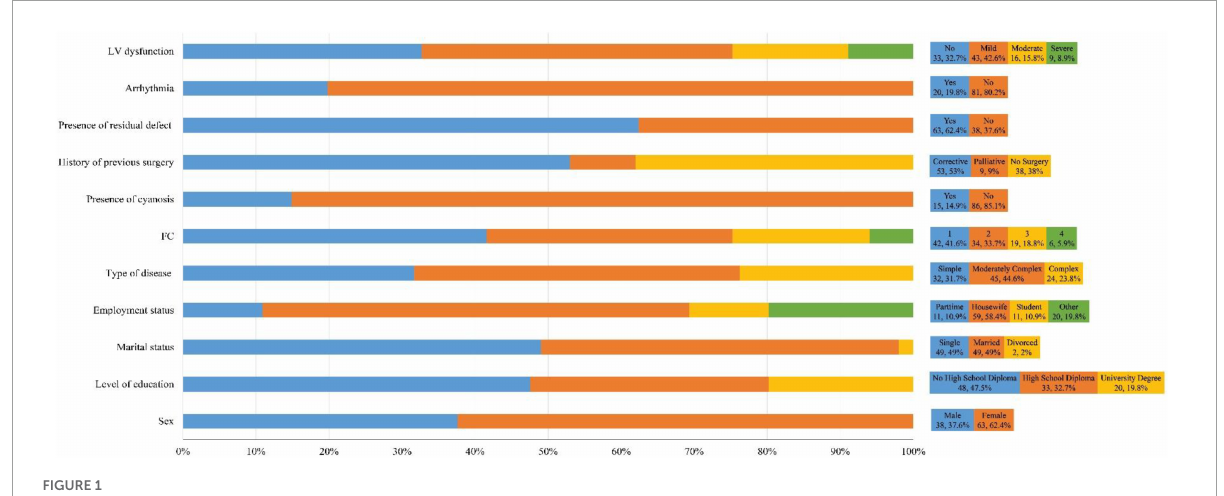
FIGURE1 Demographic data of the participants. FC, functional class; LV, left